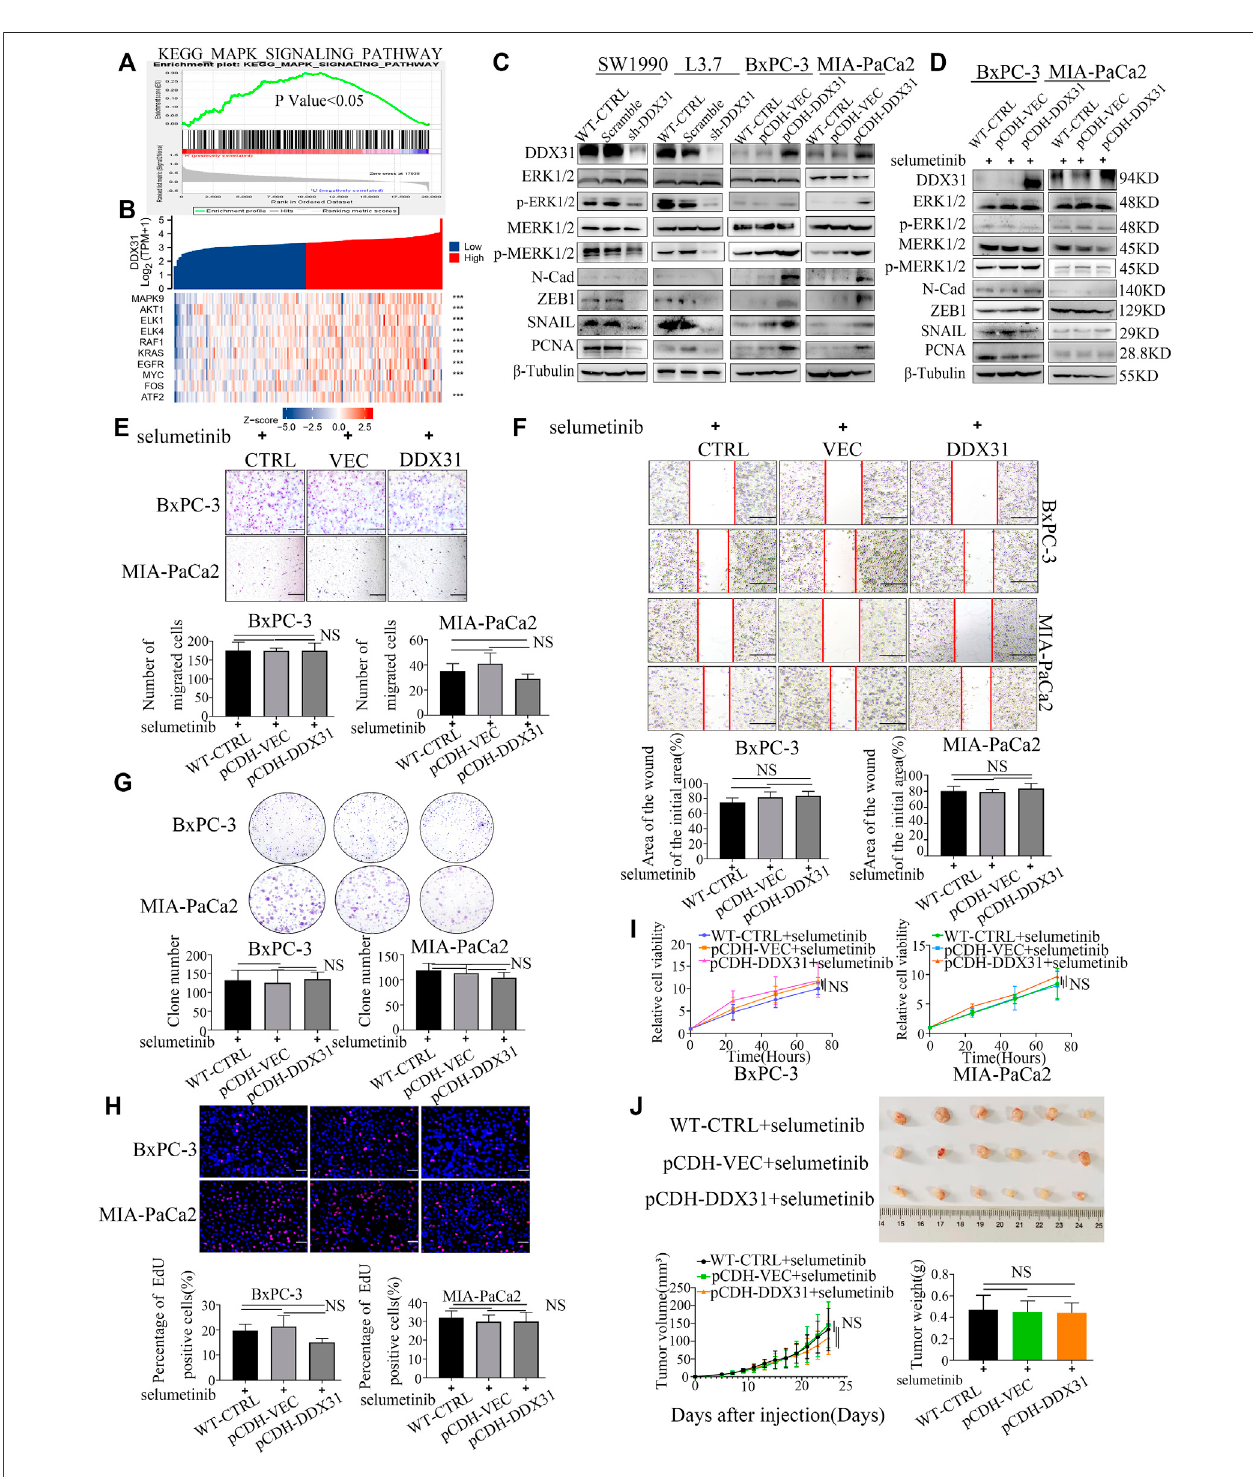
FIGURE 8 | DDX31 affects invasive metastasis and proliferation of pancreatic cancer by activating MAPK signaling pathway. (A) : GSEA was carried out according totheexpressionlevelof DDX31 ;pvalue < .05,FDR < 0.25; (B) :CorrelationanalysisbetweenDDX31andthecoregenesoftheMAPKsignalingpathway(MAPK9,AKT1, ELK1,ELK4,RAF1,KRAS,EGFR,MYC,FOS);theresultswereshownwithheatmap;pvalue < .05; (C) :TheproteinexpressionofthecoremoleculesinMAPKsignaling pathway (ERK1/2, P-ERK1/2 and P38, P-P38) within loss and gain-of DDX31 ( DDX3 1 overexpression on BxPC-3/MIA-PaCa2 cell lines, DDX31 knockdown on SW1990/L3.7celllines).EMT-relatedandproliferationmarkers(N-cadherin,Snail,ZEB1,andPCNA)werealsoshowedaccordingtotheresultsofWesternblotanalysis. (D) : Effect ofMAPK pathway inhibitor on PDAC cell lines of DDX31 overexpression was shown with western blot assays. (E,F) : Cell migration was detected by transwell